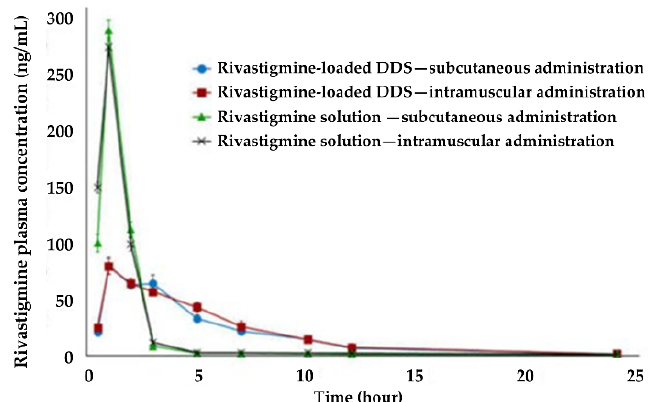
Figure 7. Rivastigmine plasma concentrations after in vivo administration in solution and through microparticles (mean ± standard deviation, n = 3). Adapted with permission from [95], copyright © 2021 MDPI.